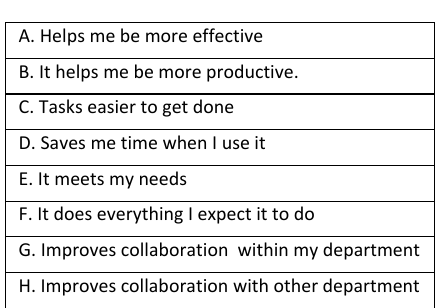
Table1. Evaluation criteria used for the